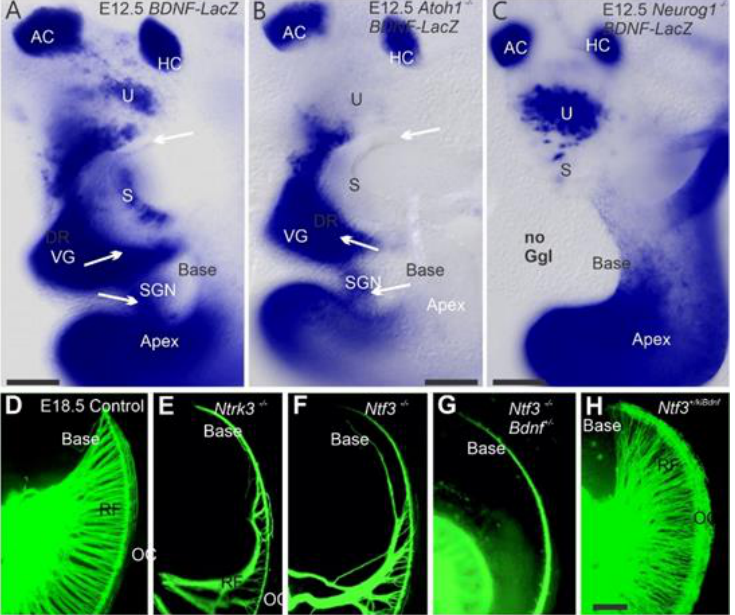
Figure 2. Innervation of the cochlea in various mutant mice. BDNF-LacZ of control mice ( A ) is compared with Atoh1 f/f ; BDNF LacZ ( B ) and Neurog1 f/f ; BDNF LacZ ( C ) Cochlear and vestibular ganglia (VG, SG) and hair cells are positive for Bdnf ( A ). Absence of Atoh1 results in the loss of Bdnf expression in the utricle and saccule hair cells and the generation of fewer neurons ( B ). Neurog1 null mutants lack all neurons but show an upregulation of Bdnf in the utricle hair cells ( C ). The cochlea’s innervation is fairly uniform along the entire length in P0 mice, as shown with lipophilic dye labeling ( D ). Various neurotrophin mutants show loss ( E , F , G ) and gain ( H ) of cochlear innervation. Ntrk3 null ( E ) and Ntf3 (NT-3) null ( F ) mutant mice show a reduction of spiral ganglion neurons innervating the basal turn of the cochlea ( E , F ). The reduction is more profound when Ntf3 null is combined with haploinsufficiency for Bdnf ( G )—inserting the Bdnf coding region into the Ntf3 gene redirected vestibular fibers to the cochlea, increasing its overall innervation. The bar is 100 μm. Modified after [12,46,47].